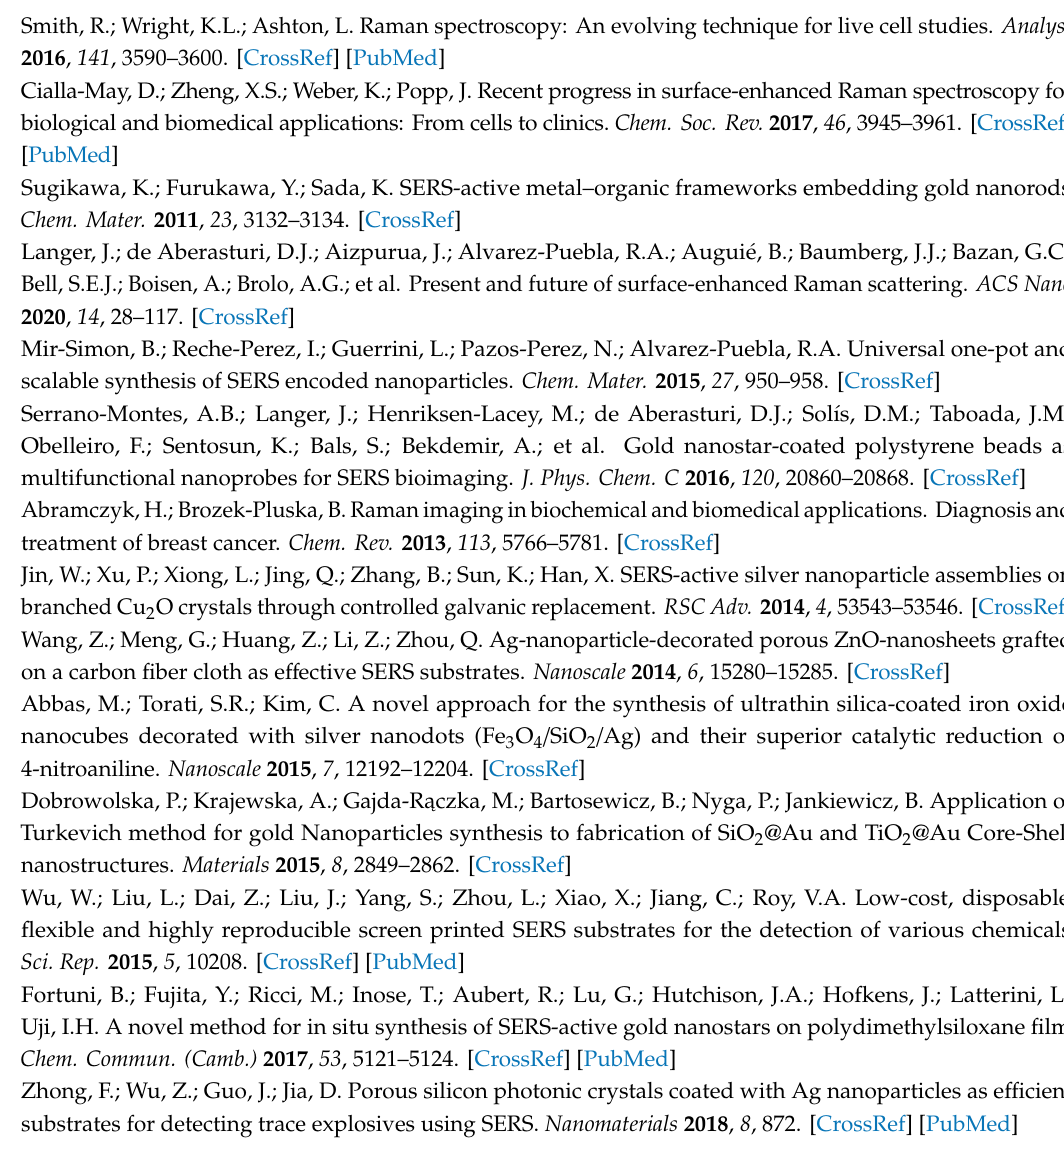
Figure S1: HRTEM image of SiPM slices (70 nm, cut by ultramicrotome) with well-distributed silicon nanocrystals inside; Figure S2: (a) microscope and (b) confocal image of hollow SiPM structure; (c) 3D fluorescent confocal image of hollow SiPM structure; Figure S3: SEM image of large scale hollow SiPM; Figure S4: TEM image of hollow SiPM obtained with low concentration ratio of APTES / L-AA (0.5 / 5); Figure S5: the size distribution histogram of gold nanoparticles; Figure S6: The extinction spectra of SiPM / Au particles; Figure S7: The Raman intensity dependence on concentrations of 4-MPy on SiPM / Au; Figure S8: the Raman spectrum of 4-MPy at 0.01 M obtained under non-SERS conditions; Figure S9. (a). SERS spectra of 10-6 M 4-MPy collected from 20 random spots on SiPM / Au composites; (b). RSD of di ff erent predominate peaks conveying both intensity and reproducibility of 20 points; Figure S10: SERS spectra of 4-MPy on SiPM / Au composites at pH 7.0 before and after storage for 7 days. Author Contributions: Conceptualization, G.Z. and L.Z.; methodology and validation, L.C.; writing—original